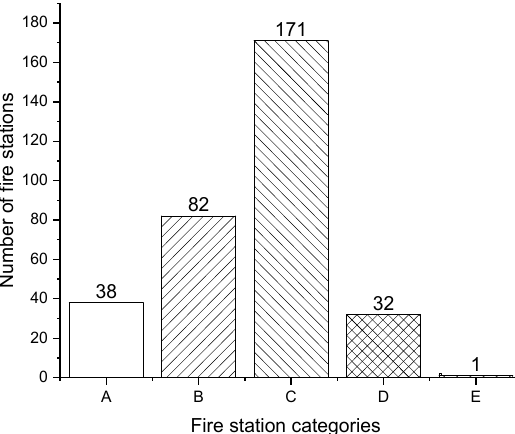
Figure 2. Fire station categories in Malaysia.